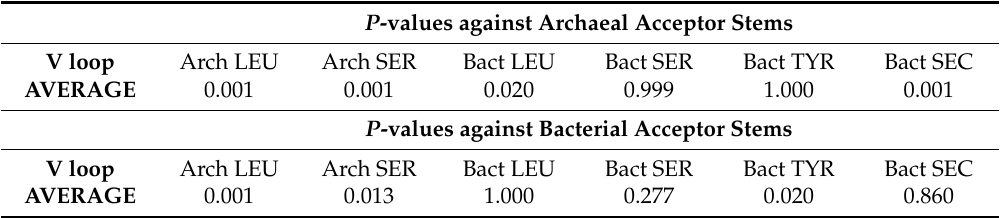
Table 1. Homology of type-II V loops to acceptor stems (Arch: archaea; Bact: bacteria). P -values against Archaeal Acceptor Stems V